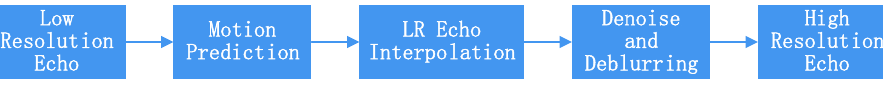
Figure 2. Reconstruction process.